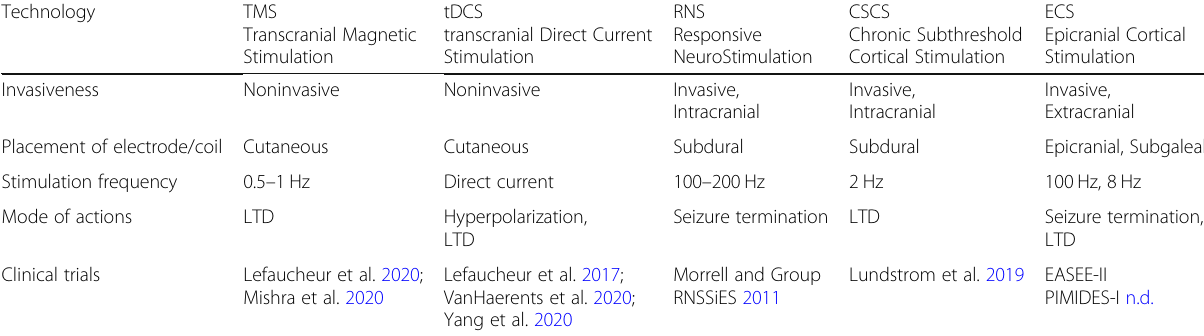
Table 1 Bioelectronic technologies for cortical stimulation in focal epilepsies